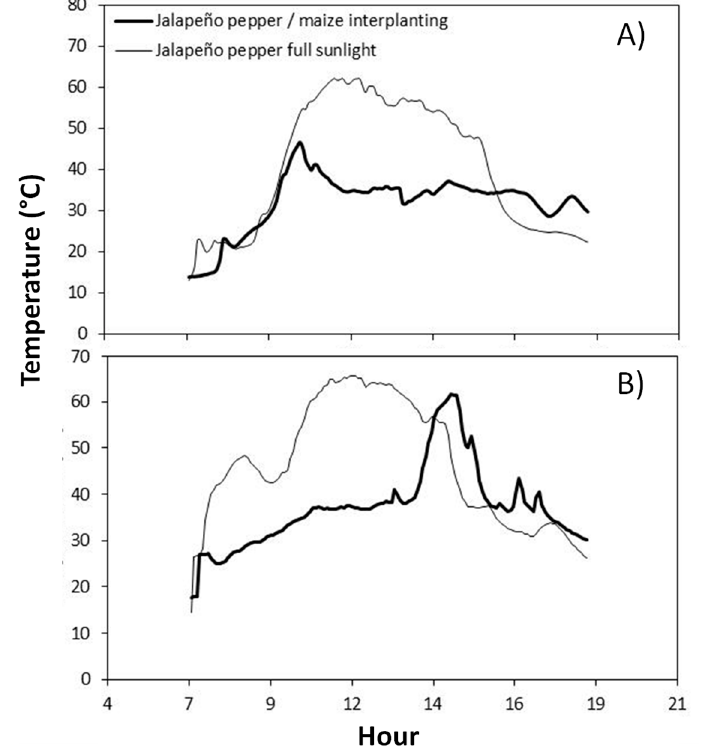
Figure 2. Temperatures recorded at a jalapeño pepper canopy level as affected by intercropping, on ( A ) 16 April and ( B ) 12 May 2016.